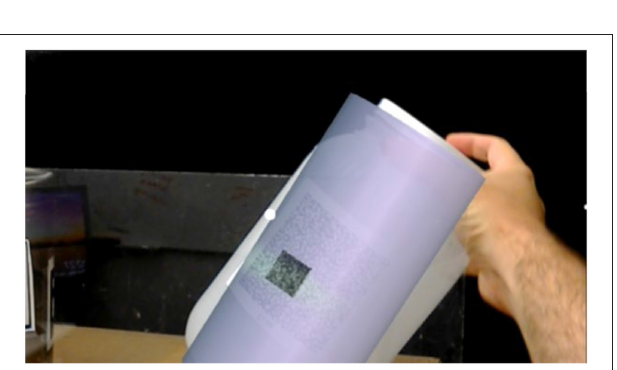
FIGURE 14 | QR code on canister allows for tracking of position and pose of canister. A holographic cylinder is overlaid on the canister to provide feedback to the user that the canister is detected and being tracked.